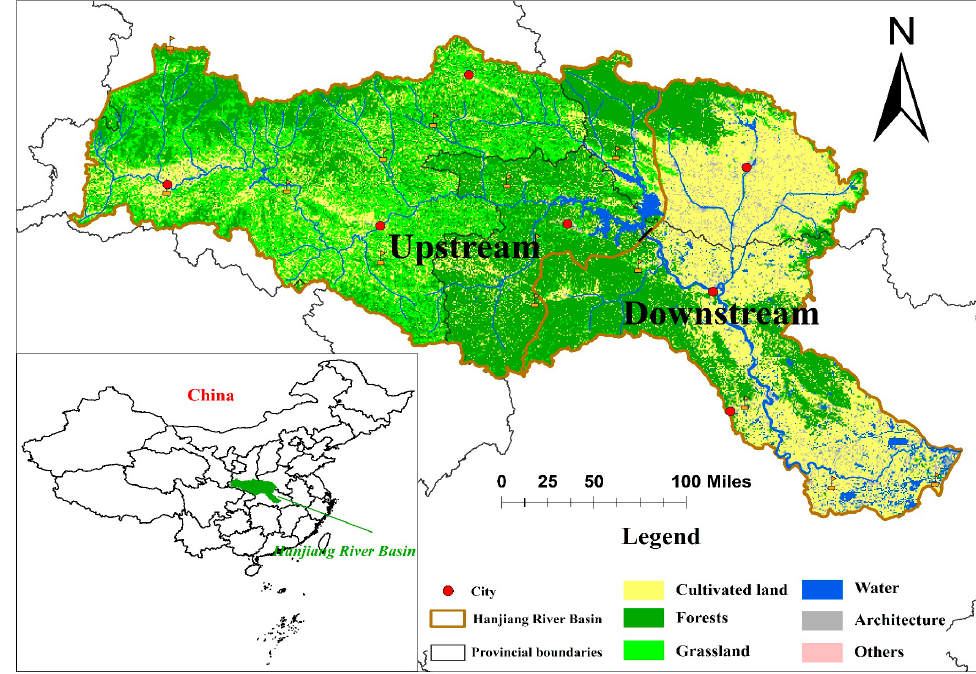
Figure 1. Location of the HJRB.